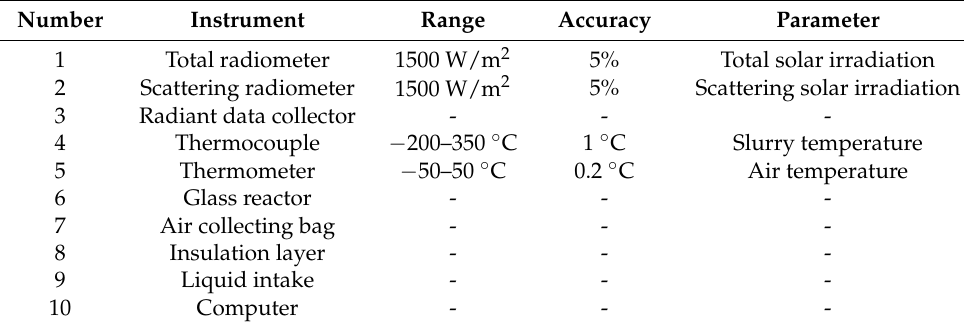
Figure 1. Structure drawing and component detail drawing of the direct-absorption anaerobic reactor. Table 1. Parameter index of experimental instrument.